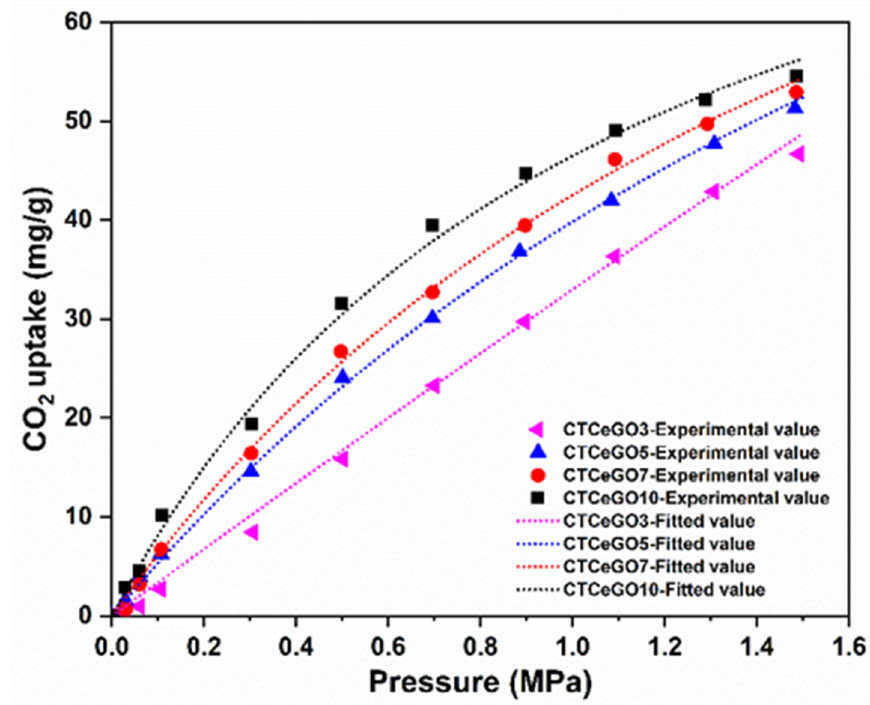
Figure 8. CO 2 sorption affinity of the synthesized CTA-CeO 2 @GO membranes with different concentrations of GO.